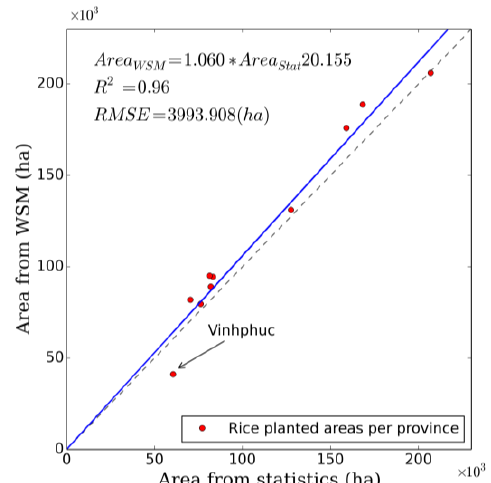
Figure 8. Retrieved rice planted areas per province (in hectares) for the sum of double cropped rice vs. statistical rice planted areas. The thick green line represents the linear regression between the two datasets.